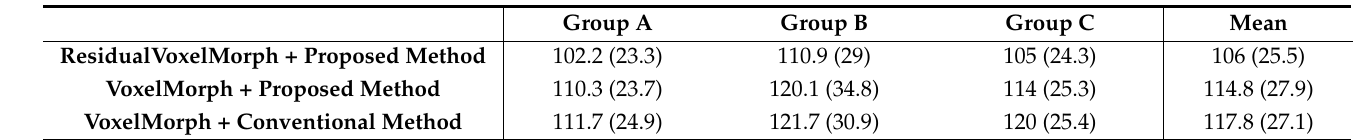
Table 4. RMSE average values in the abnormal cases of all evaluated methods. Values in parentheses represent standard deviation of RMSE.